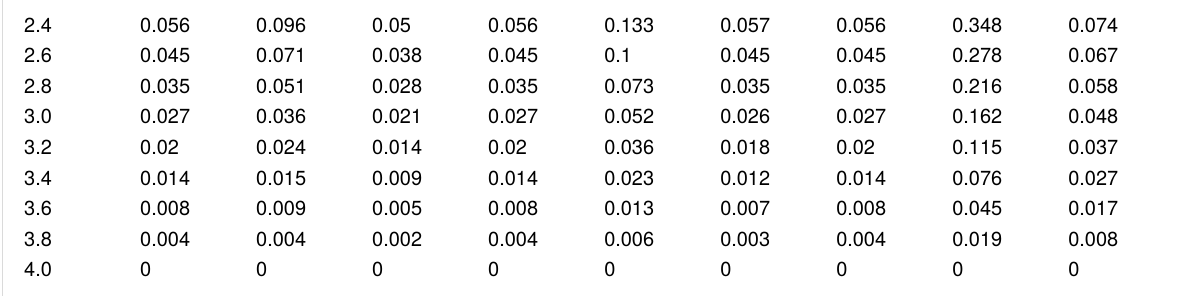
Table 3: Computation of streamwise velocity, temperature and concentration profiles for different values of the heat generation/absorption coefficient, Q . (continued)